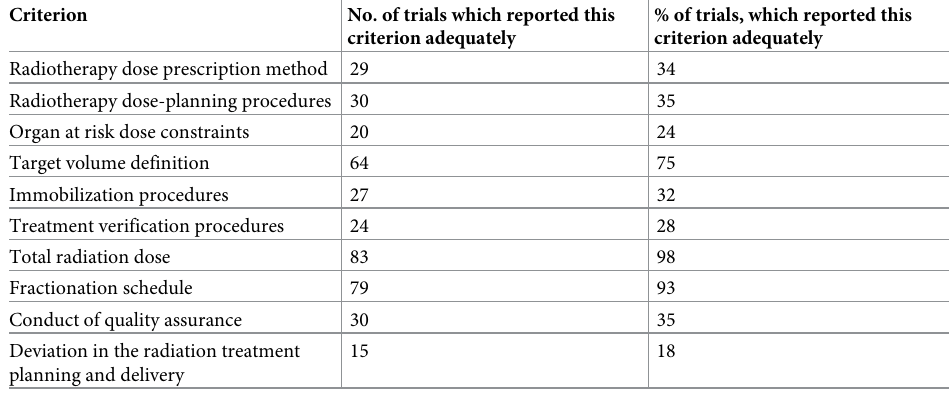
Table 3. Quality of cranial radiotherapy technique reporting (number of trials that reported each criterion adequately).